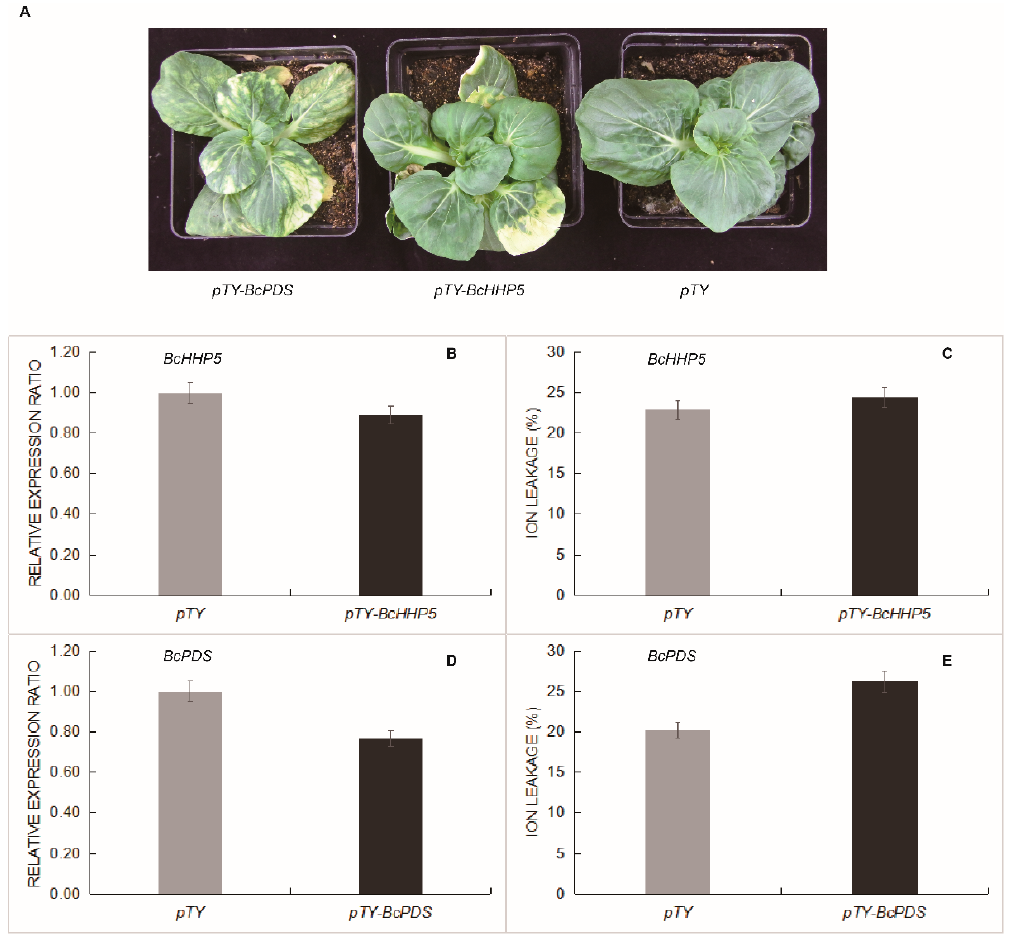
Figure 8. BcHHP5 silencing in Pak-choi. ( A ) The Pak-choi leaf phenotype (2.5 cm scale) after BcHHP5 -silencing test; ( B ) relative expression of BcHHP5 ; ( C ) ion leakage of Pak-choi leaves; ( D ) relative expression of BcPDS ; ( E ) ion leakage of Pak-choi leaves.